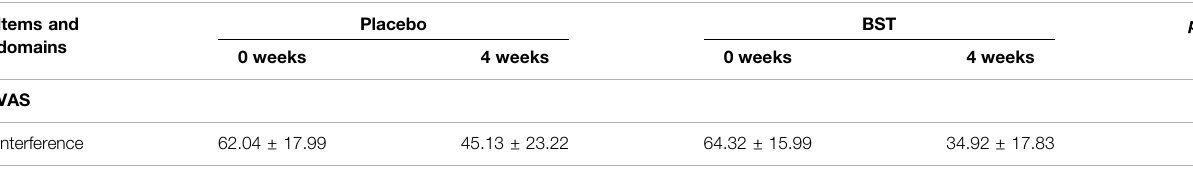
TABLE 4 | Visual Analogue Scale (VAS) scores.